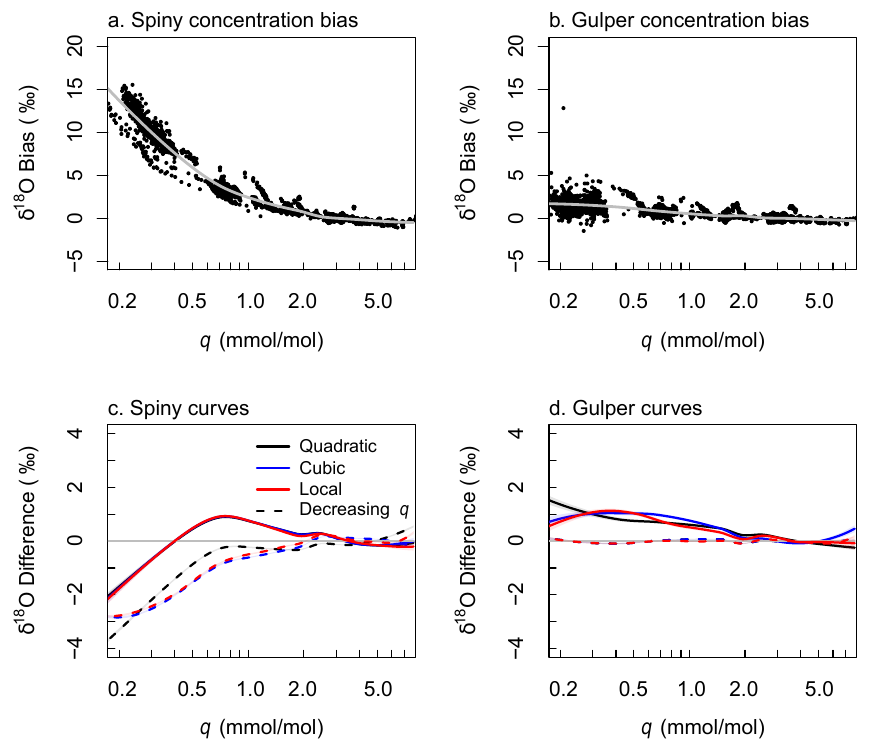
Figure 2. (a–b) The concentration dependences of the Summit analyzers shown normalized to a reference humidity (see Sect. 2.4). The gray lines are the locally weighted polynomial regressions used as reference curves in panels (c–d) . (c–d) Curve-fitting and hysteresis effects on the Summit concentration-dependence characterizations. Lines represent the isotopic differences that would result if fitting data from the extended concentration-dependence calibrations in which the water vapor volume mixing ratio progressively increased (solid lines) or decreased (dashed lines), compared with the concentration dependence obtained from all Summit concentration–calibration data (the zero line is shown in gray for clarity). Characterizations are shown as a function of q – the water vapor volume mixing ratio – on a log scale for the various fitting procedures described in the legend and text. Prediction errors are represented by shaded envelopes around each curve.